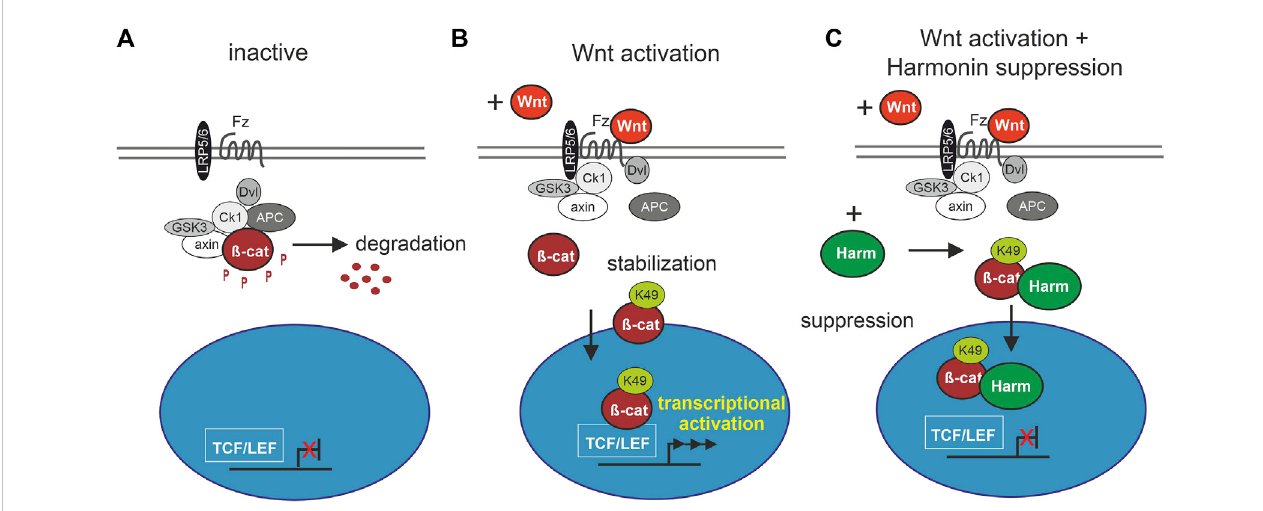
FIGURE 8 Schematic drawing of involvement of harmonin in cWnt signaling pathway. (A) In the inactive cWnt signaling pathway, absence of Wnt ligands leads to phosphorylation (P) of β -catenin ( β -cat) by the destruction complex (grey and white circles) followed by protein degradation. (B) In presence of Wnt ligands, thepathwayisactivatedbybindingofWnttothereceptorFrizzled(Fz),preventingtheformationofthedestructioncomplex. β -catenincanthenbeacetylated at K49 ( β -cat_K49) resulting in its stabilization and nuclear translocation where it serves as transcriptional coactivator of TCF/LEF (T cell factor/lymphoid enhancing factor) Wnt target genes. (C) Harmonin (Harm) as negative regulator of cWnt signaling, suppresses the pathway by binding to β -cat_K49. The protein complex can still translocate to the nucleus but further transcription of cWnt target genes is blocked. Fz (Frizzled), LRP5/6 (lipoprotein receptor- related protein), Dvl (Dishevelled), APC (adenomatosis polyposis coli), axin, Ck1 (casein kinase 1 α ), GSK3 (glycogen synthase kinase